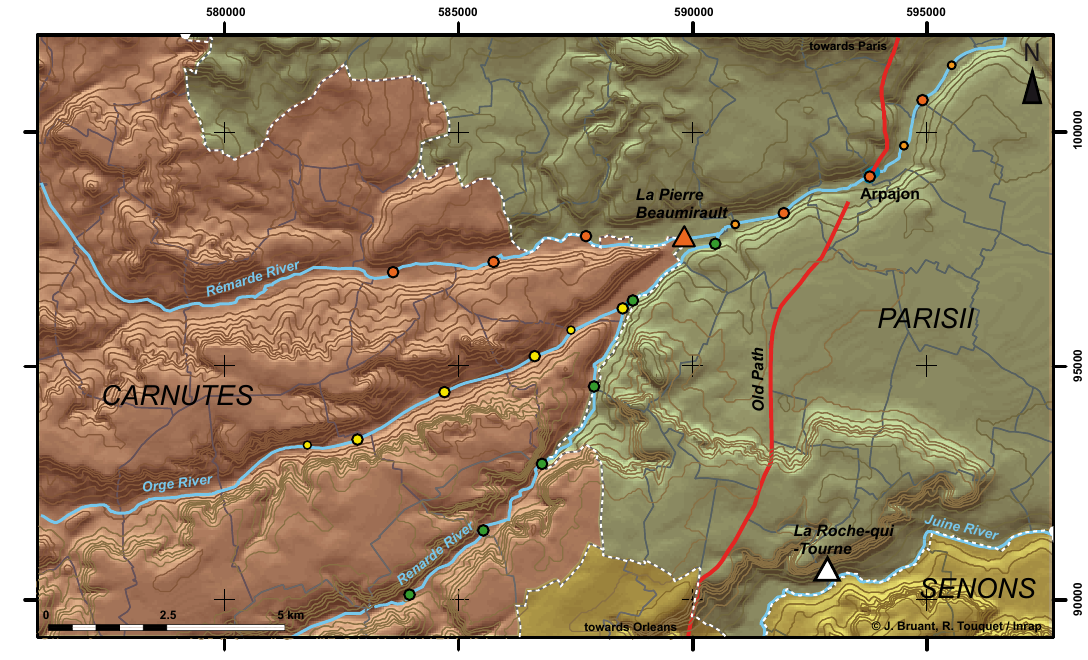
© J. Bruant, R. Touquet / Inrap